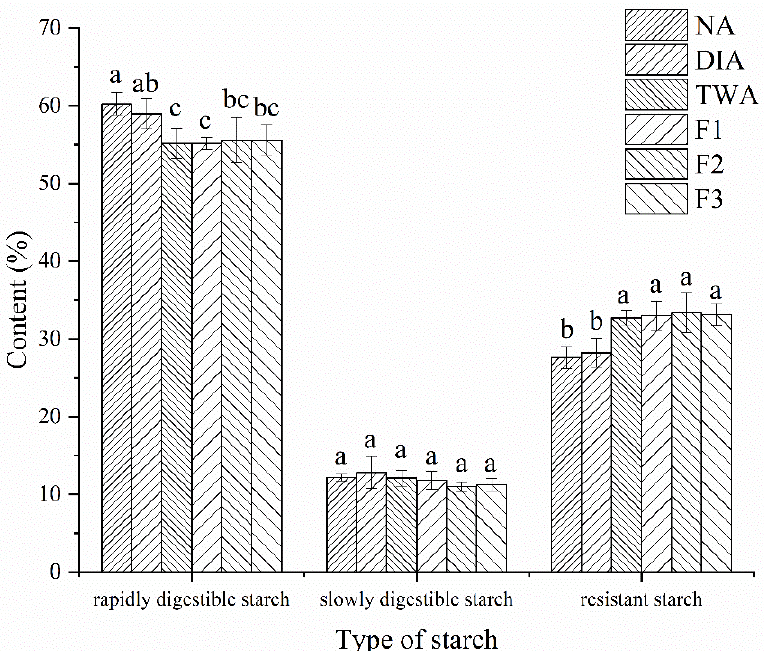
Figure 6. Effect of coloration with BRA and the addition of chelator formulation on the in vitro digestion behavior of the steamed cold noodles that were not colored (NA), colored with deionized water-dissolved BRA (DIA), colored with tap water-dissolved BRA (TWA), and colored with tap water-dissolved BRA containing the three optimized chelator formulations (F1–F3). Values of the same series without the same letter(s) are significantly different at p < 0.05.